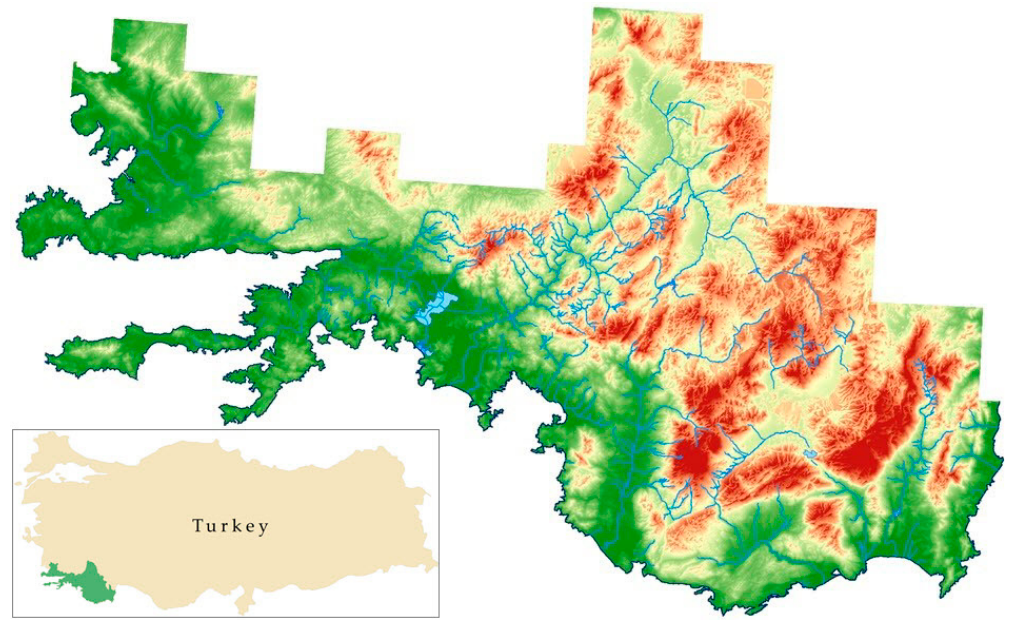
Figure 5. The DEM (digital elevation model) and hydrological network in the Western Mediterranean